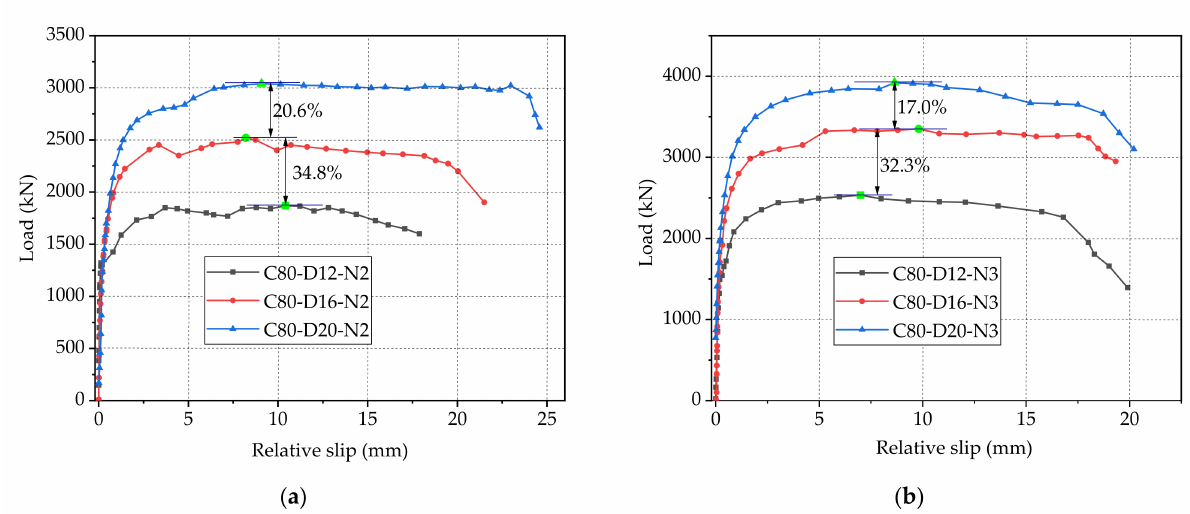
Figure 8. Load-slip curves of with different diameters of penetrating rebar: ( a ) C80 concrete and 2-hole steel plate; ( b ) C80 concrete and 3-hole steel